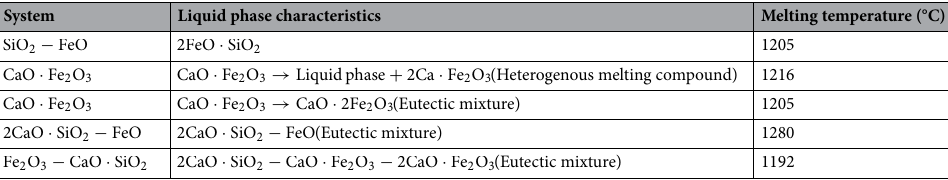
Table 4. Main fusible compounds and eutectic mixtures in the sintering process.